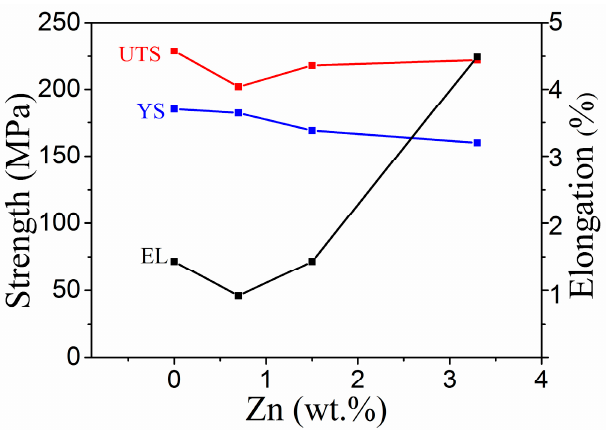
Figure 6. Variation in the mechanical properties of the alloy at varying Zn